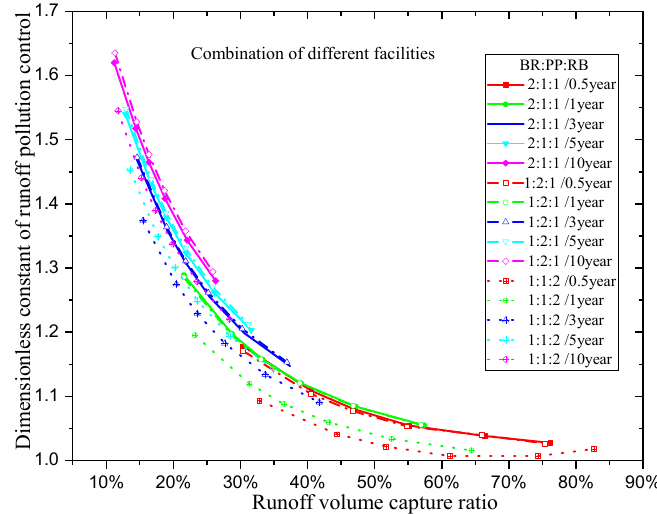
Figure 7. Dc value change curve of different facility combinations.